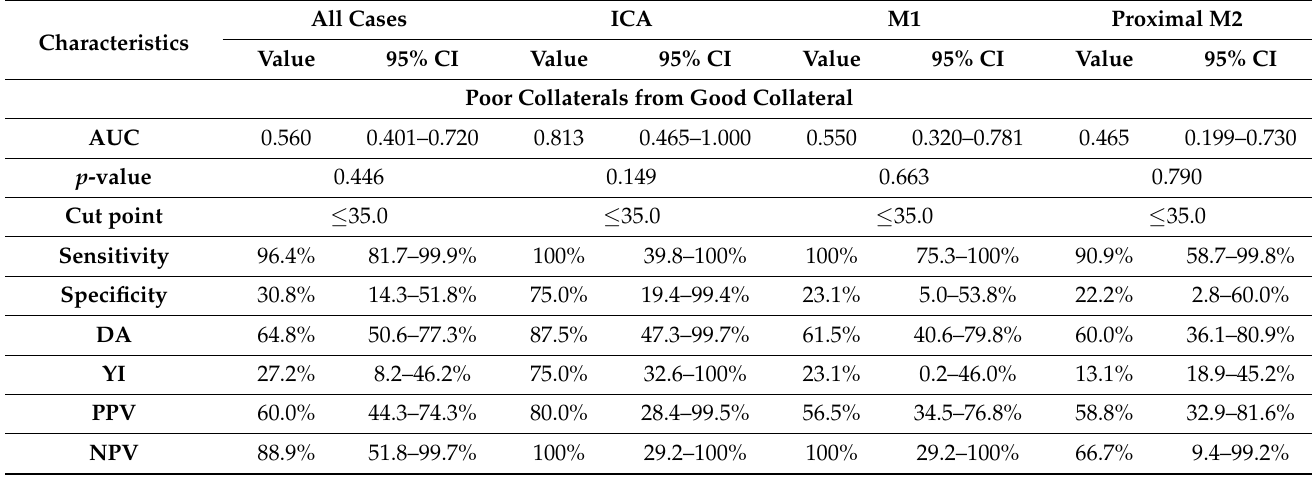
Table 4. Diagnostic performance and characteristics of BMI in predicting poor